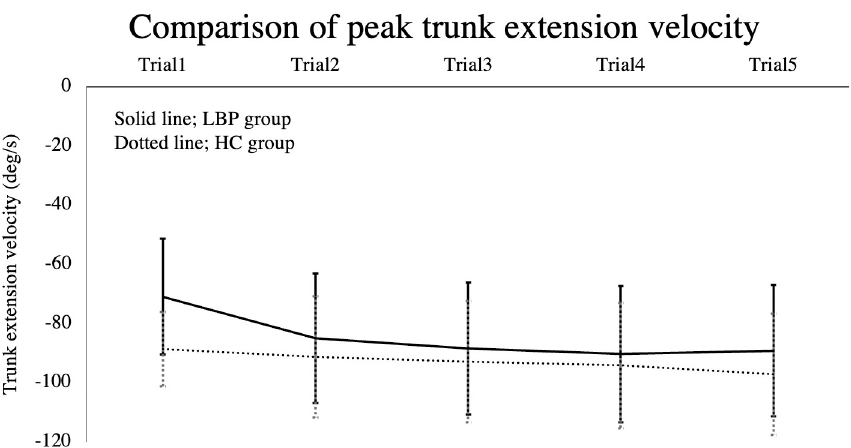
Fig 3. Comparison of peak trunk extension velocity at each trial in the two groups. The LBP group showed slower trunk extension in Trial 1 compared to the HC group.